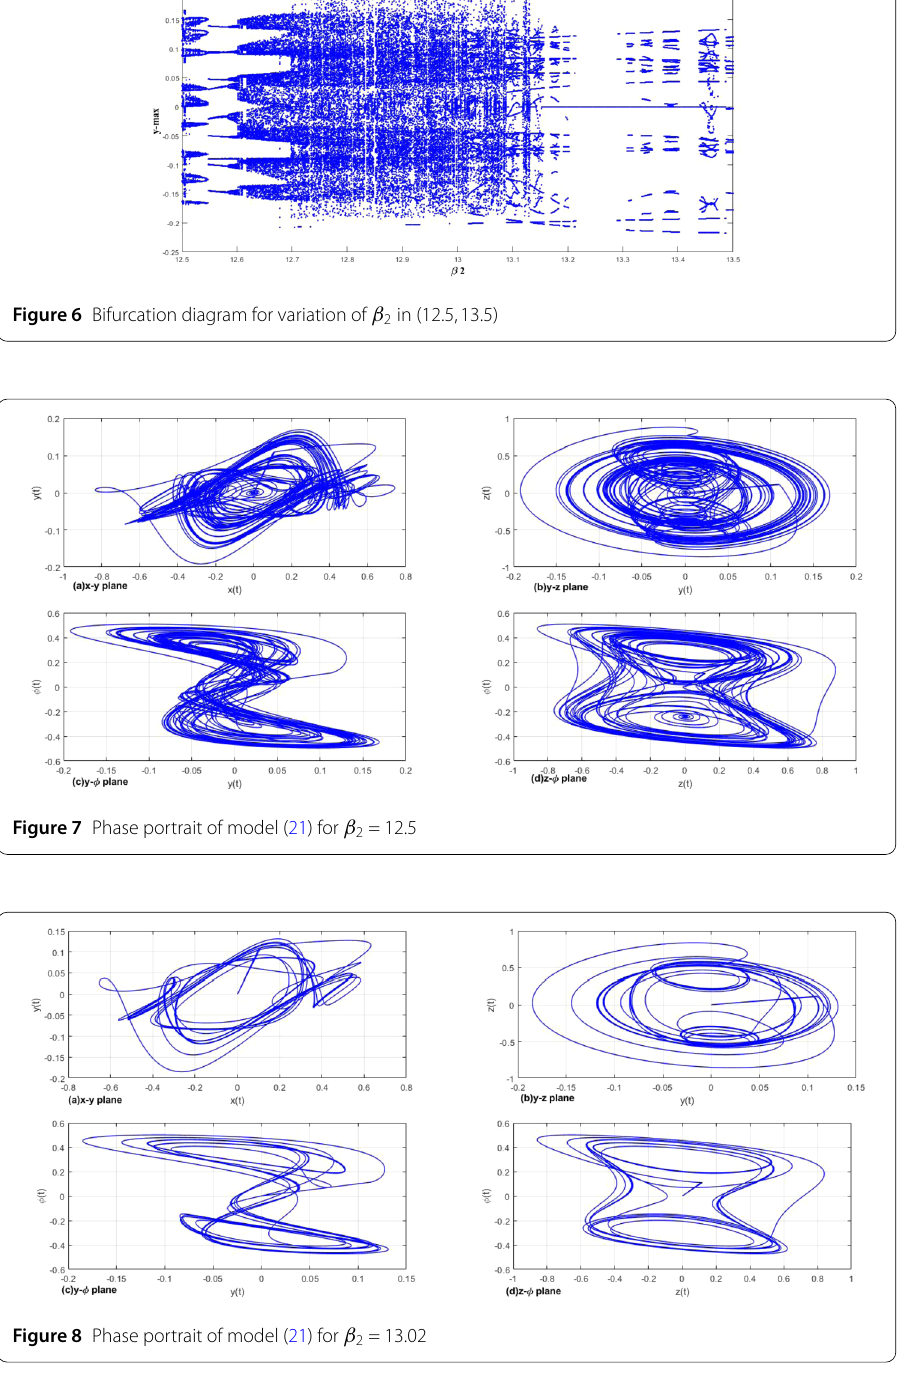
β 2 is made to vary in the interval (12.5,13.5) with an increment of 0.001. The